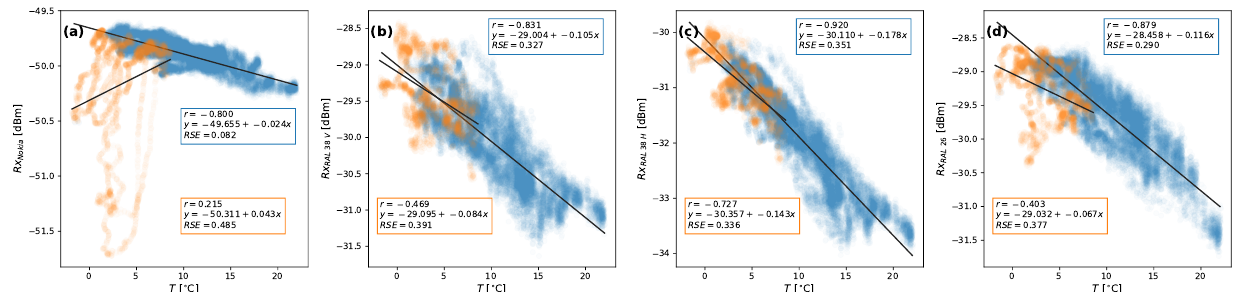
Figure 11. Scatterplots of link received power vs. ambient air temperature measured at the “Veenkampen” meteorological station. Blue dots indicate times when relative humidity (as measured at “Veenkampen”) is < 90%; orange dots indicate times when relative humidity > 90%. Solid lines indicate linear least-squares regression fit. Links: (a) Nokia Flexihopper, (b) RAL 38GHz vertical, (c) RAL 38GHz horizontal, and (d) RAL